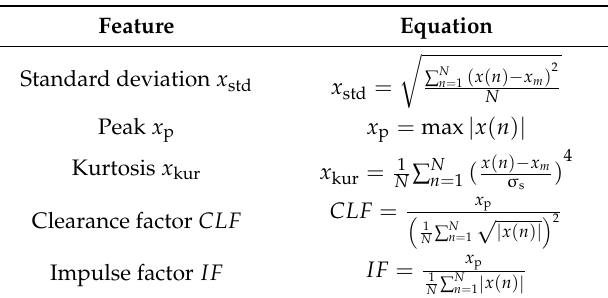
Table 1. Five time domain feature parameters 1 .